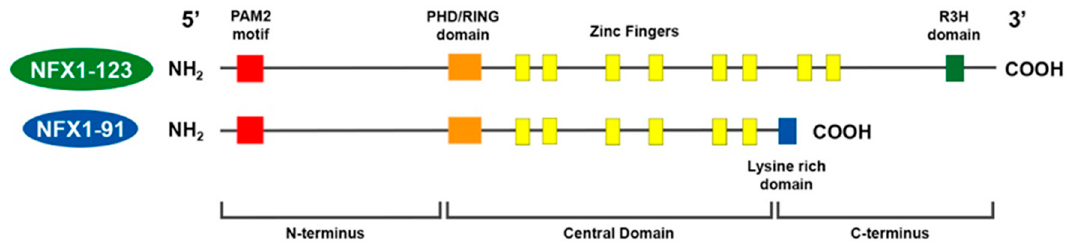
Figure 1. Model of NFX1 splice variants in humans. NFX1-123 and NFX1-91 share a common N-terminus, with a PAM2 motif, and Central Domain, with a PHD/RING domain and six cysteine-rich zinc-like fingers. NFX1-91 has a truncated C-terminus that is lysine-rich. NFX1-123 has a unique C-terminus with two additional zinc-like fingers and an R3H domain.